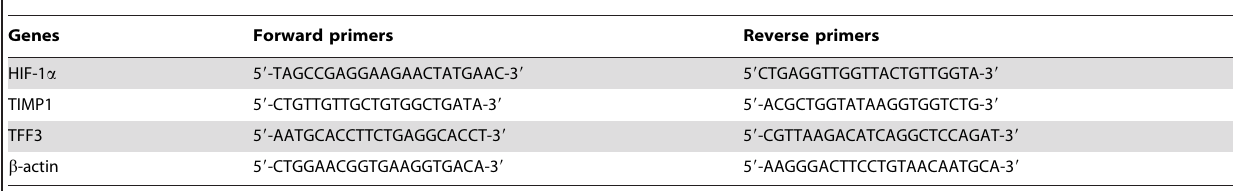
Table 2. Primer sequences used for qRT-PCR